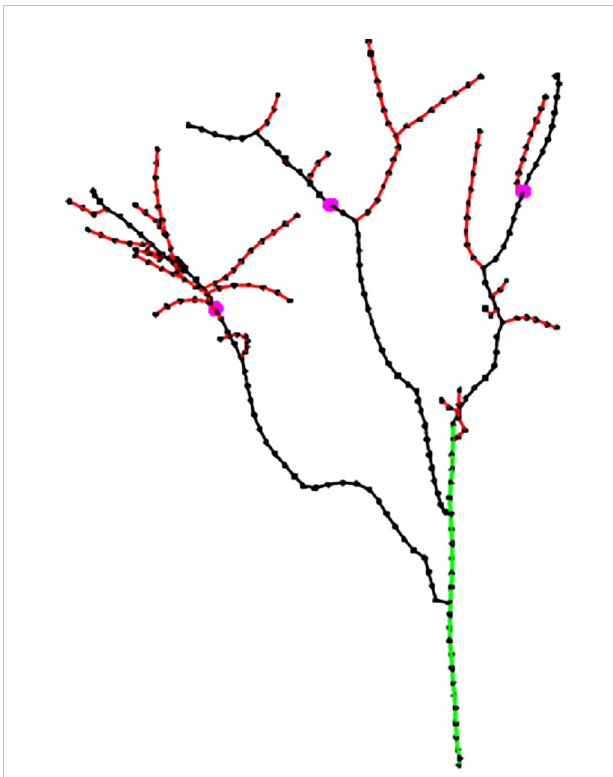
FIGURE 9 Comparison of point cloud registration